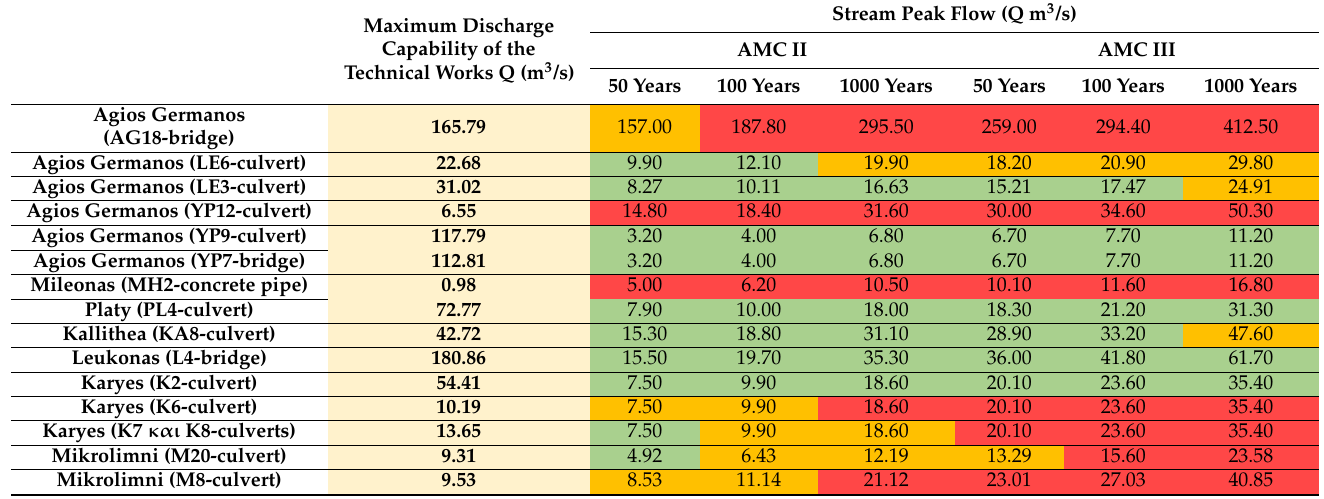
In Table 10, the maximum discharge capability of the selected hydrotechnical works and the peak discharges for 50, 100 and 1000 return periods of the respective streams are presented. According to the results, there are many cases of the selected hydrotechnical works that are proven not sufficient to discharge the expected peak flows for the examined return periods. Specifically, in Table 10 the red values (red cells) indicate the circumstances, in which the technical works will fail to discharge the expected peak flows. The marginal cases are marked in orange, while the cases, in which the technical works will discharge the expected peak flows are presented in green color. Accepting the known uncertainties of the hydrological models in ungauged watersheds, the marginal values were based on a reasonable range between ± 20%, which could be characterized as acceptable in hydrological modeling [10,56,71,72]. Table 10. Maximum discharge capability of the technical works and the stream peak flow for 50, 100 and 1000 years return periods. Maximum Discharge Capability of